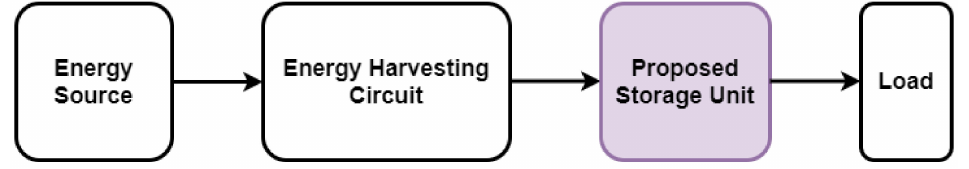
Figure 1. Block diagram of an energy harvesting